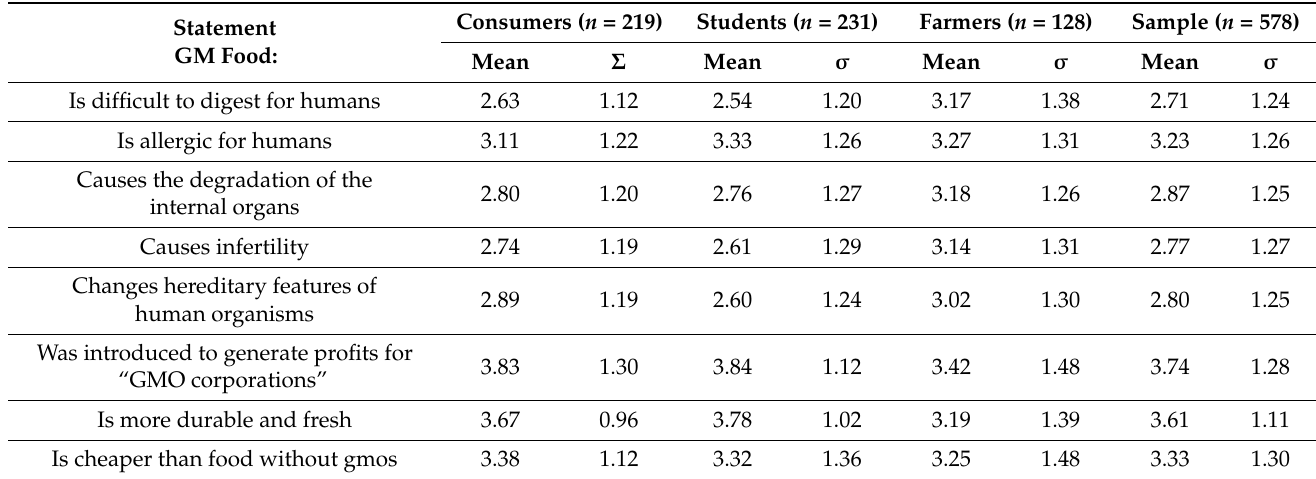
Table 3. To what extent do you agree with the following statements regarding GM foods?